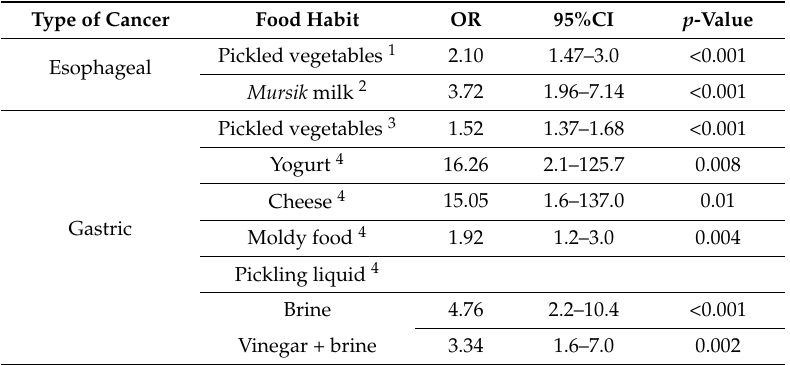
Table 3. Odds ratios (OR) and 95% confidence intervals (CI) for gastric and esophageal cancer in relation to selected food habits based on epidemiological surveys from high-risk areas. Type of Cancer Food Habit